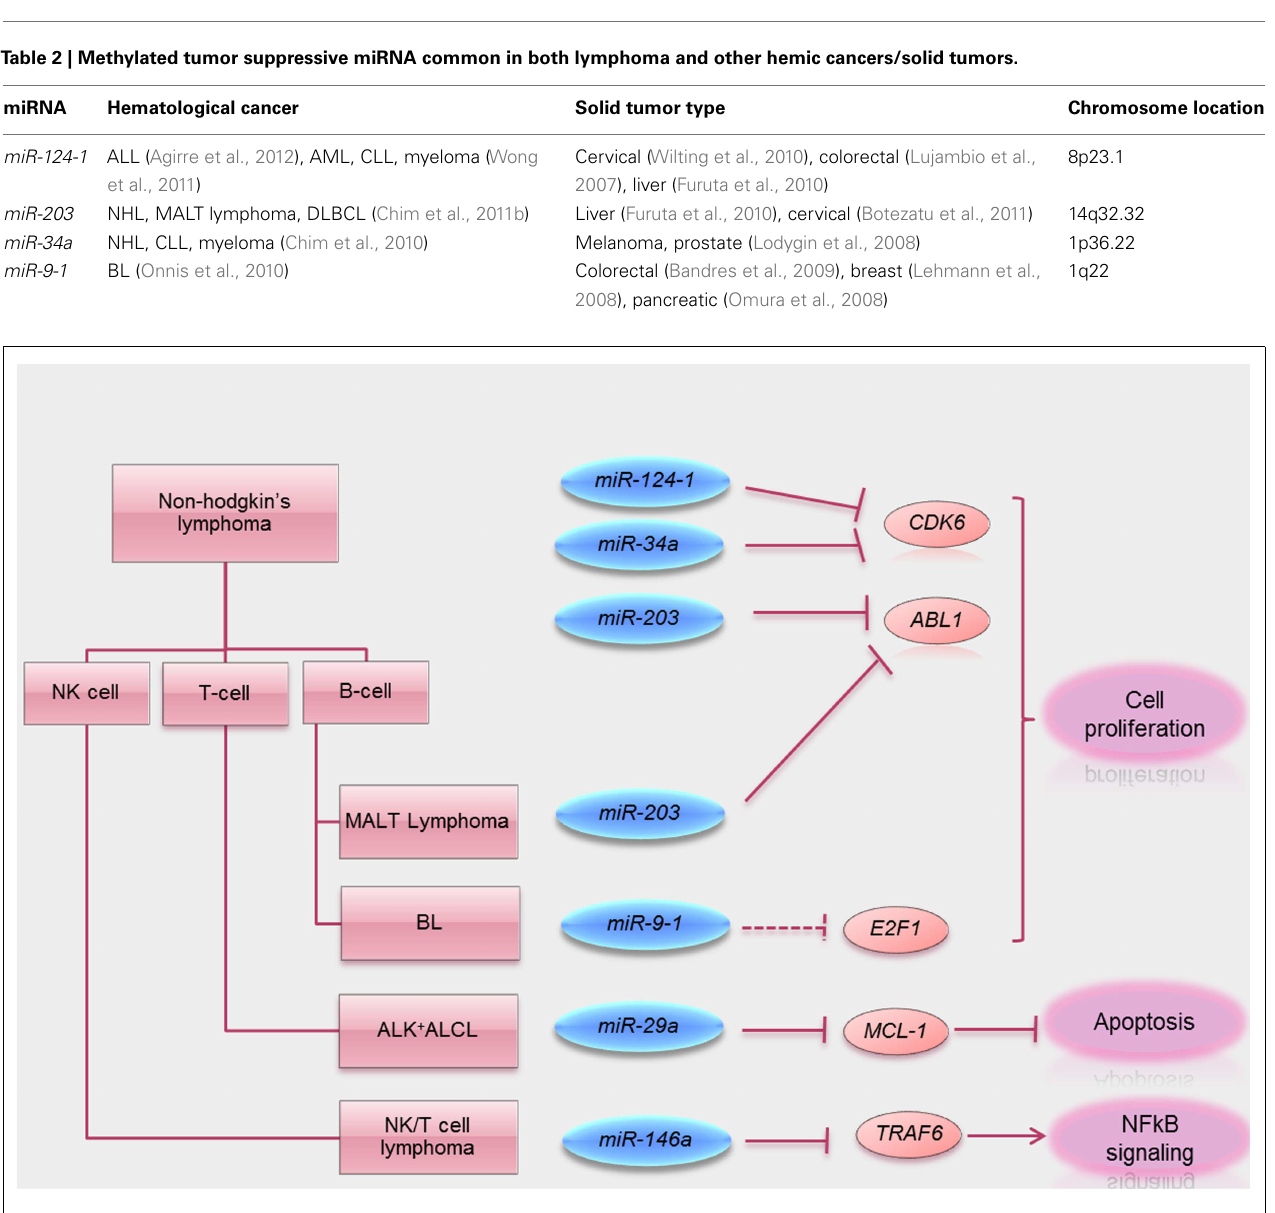
oncogenes (solid line) and putative target oncogenes (dotted lines) silenced by these tumor suppressive miRNA. A key tumor suppressive function of these miRNA is also